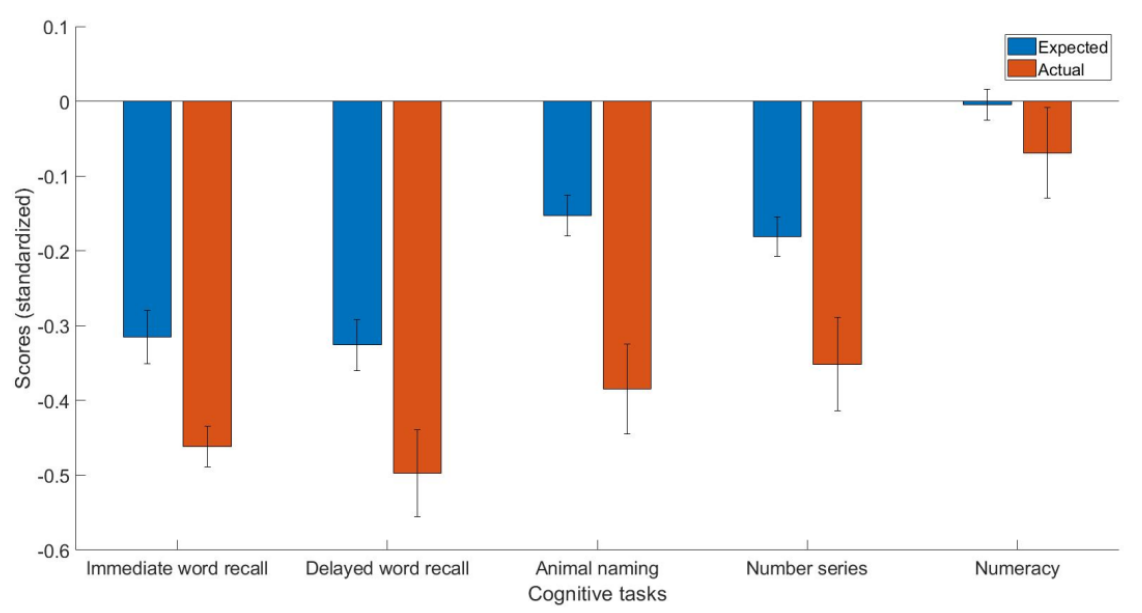
Figure 1. The expected and actual cognitive task scores in people with CHD.